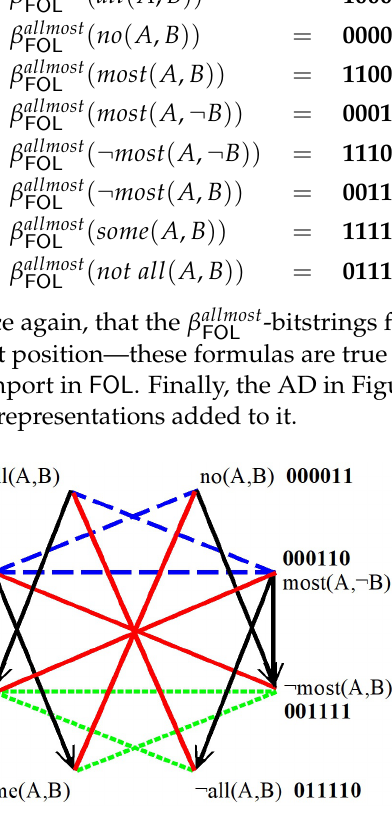
Figure 6. Octagon with bitstrings of length 6 for F allmost , relative to FOL